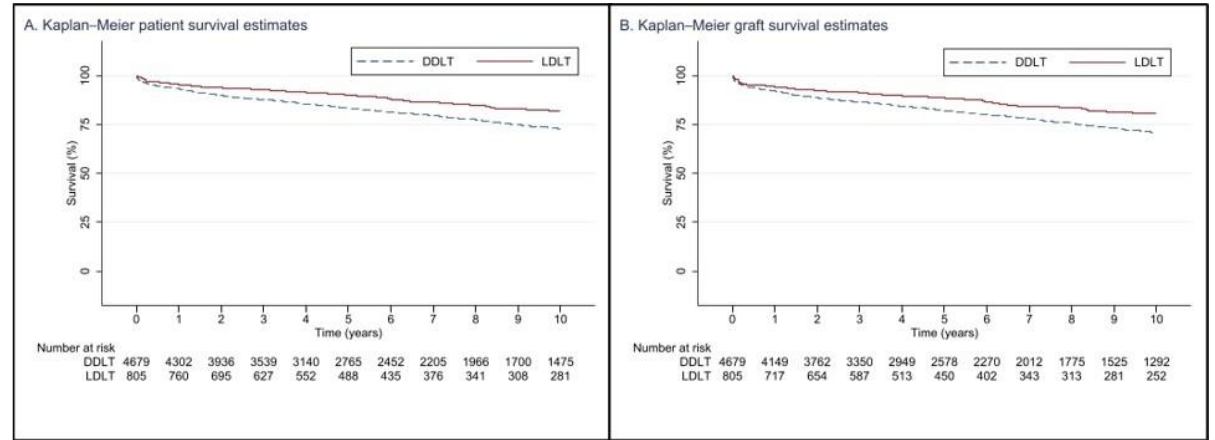
Figure 1. Kaplan – Meier curves demonstrating post-transplant patient and graft survival when an- Figure 1. Kaplan–Meier curves demonstrating post-transplant patient and graft survival when alyzed by donor type. analyzed by donor